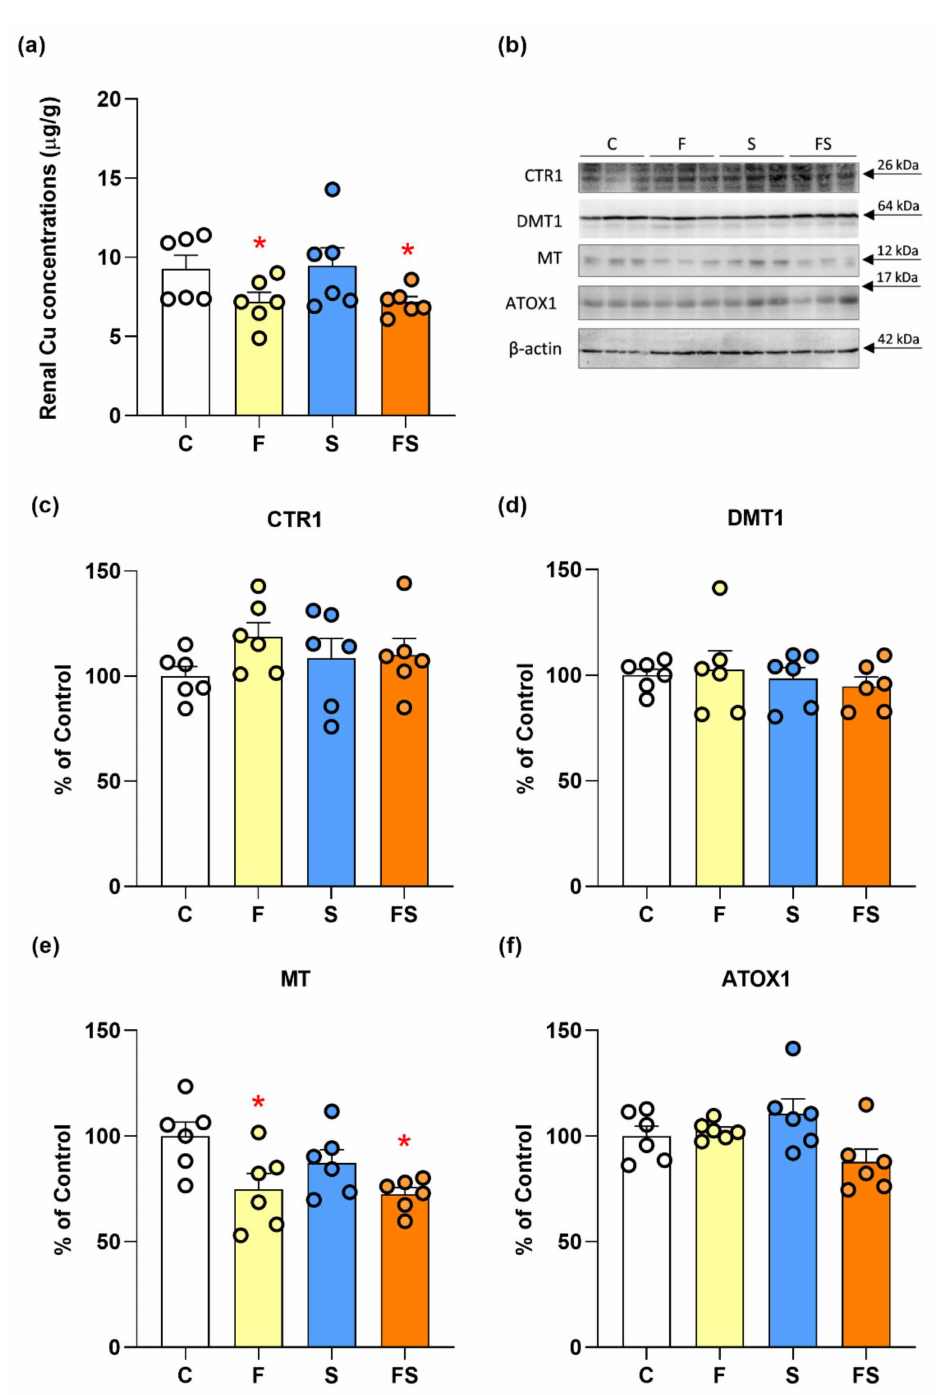
Figure 1. Effects of liquid fructose supplementation and/or stress on copper concentration and proteins involved in copper import (CTR1 and DMT1), storage (MT), and transport to Golgi network (ATOX1). Groups: control (C), fructose-fed (F), stress (S) and fructose + stress (FS). Renal copper concentrations ( a ), representative Western blots ( b ) and protein level of CTR1 ( c ), DMT1 ( d ) MT ( e ) and ATOX1 ( f ) in renal whole cell extracts. Scatter plot with bar graphs represent the means ± SEMs for each protein normalized to β -actin and expressed relative to controls ( n = 6 animals/group). Two-way ANOVA was used to evaluate the effects of fructose and stress, and their interaction. Asterisk denotes statistically significant main effect of fructose. p <